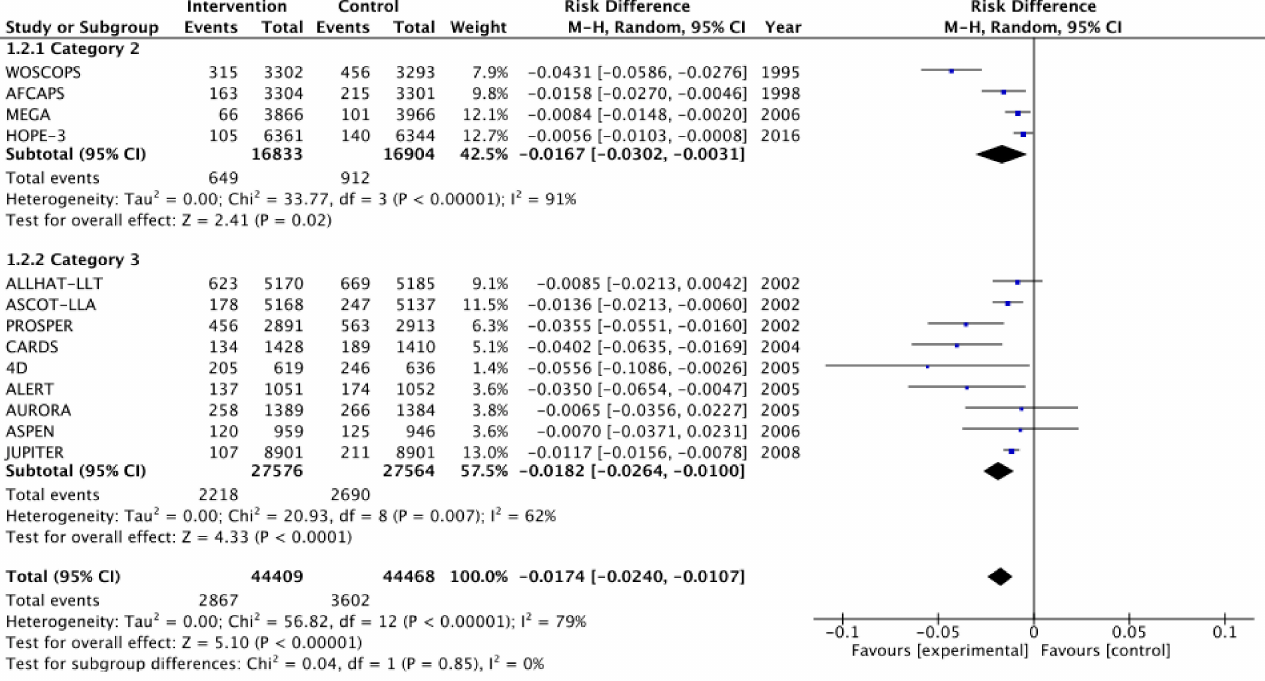
Figure 5. Risk difference across Category 2 and 3 studies for the secondary outcome of all CHD events combined. Heterogeneity across studies was high, so random effects were used for the meta-analysis (Heterogeneity: Chi 2 = 56.82, p < 0.001, I 2 =